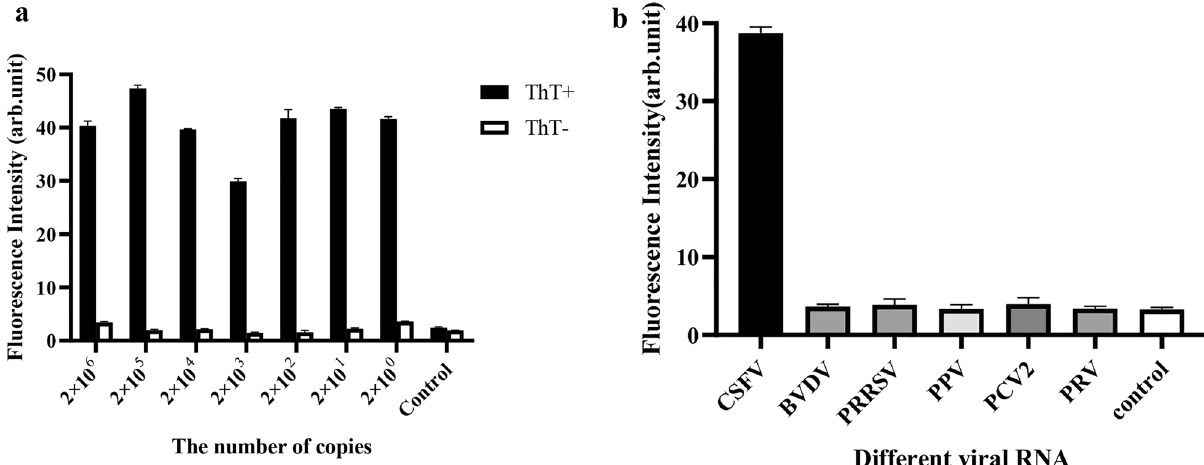
Figure 3. Sensitivity ( a ) and specificity ( b ) for CSFV detection by G4-ThT-NASBA system. ( a ) Detection sensitivity. Amplification products with different copies CSFV-E2 RNA use ThT to detect. The fluorescence values were measured at 425 nm excitation and 490 nm emission and normalized to the value of negative control. Negative control: the group with no template added to the detection system. The data represent the mean ± S.D. of three independent experiments. ( b ) Detection specificity. Total RNA extracted from different viruses infected cells were detected for CSFV RNA. The fluorescence values were measured at 425 nm excitation and 490 nm emission and normalized to the value of negative control (Ct). Ct: negative control with no template added to the detection system. The data represent the mean ± S.D. of three independent experiments.